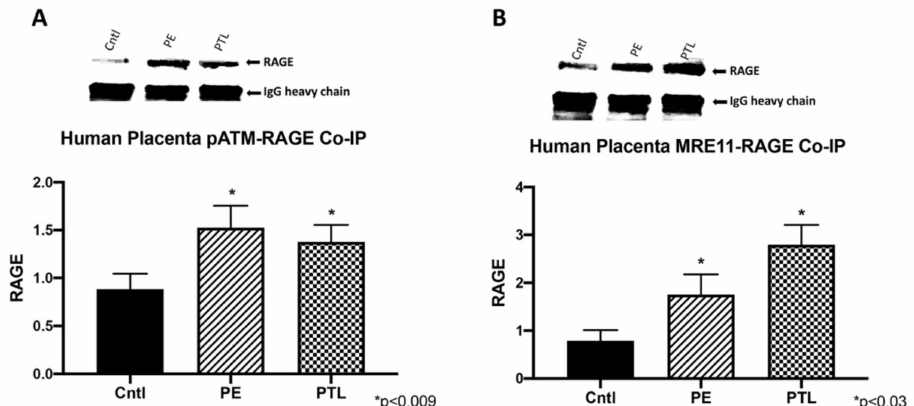
Figure 3. RAGE interacts with ATM and MRE11 during placental DNA-DSBs. ( A ) Increased pATM- RAGE complex in PE and PTL samples when compared to controls. ( B ) Increased MRE11-RAGE complex in PE and PTL samples when compared to